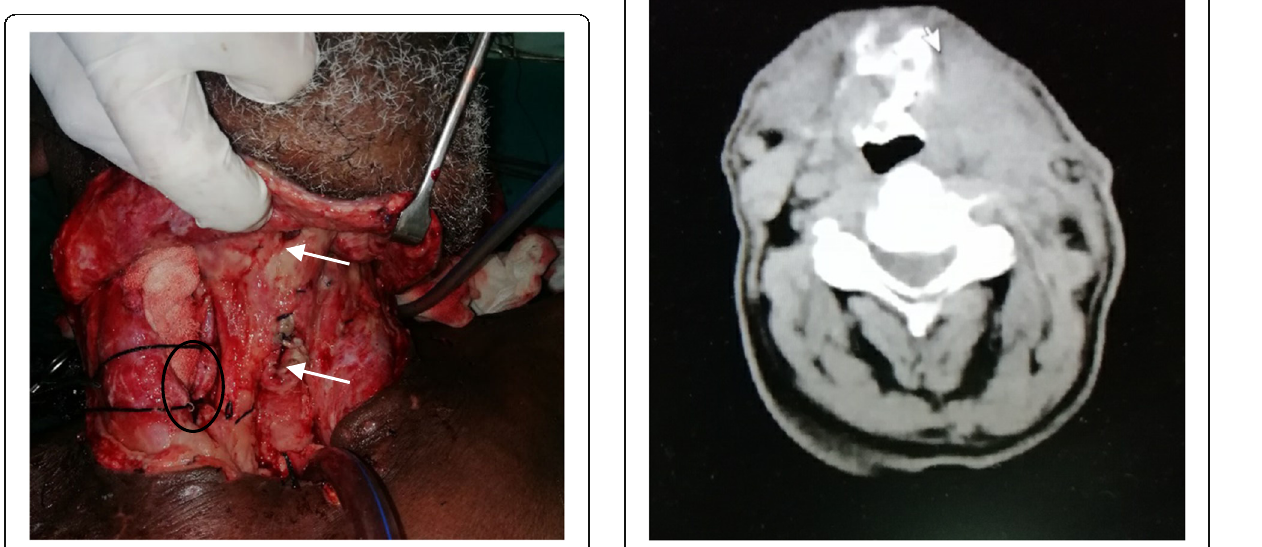
Fig. 3 Intraoperative left-sided ligated IJV (black circle) and 2 sites of pharyngocutaneous fistulas (white arrows)